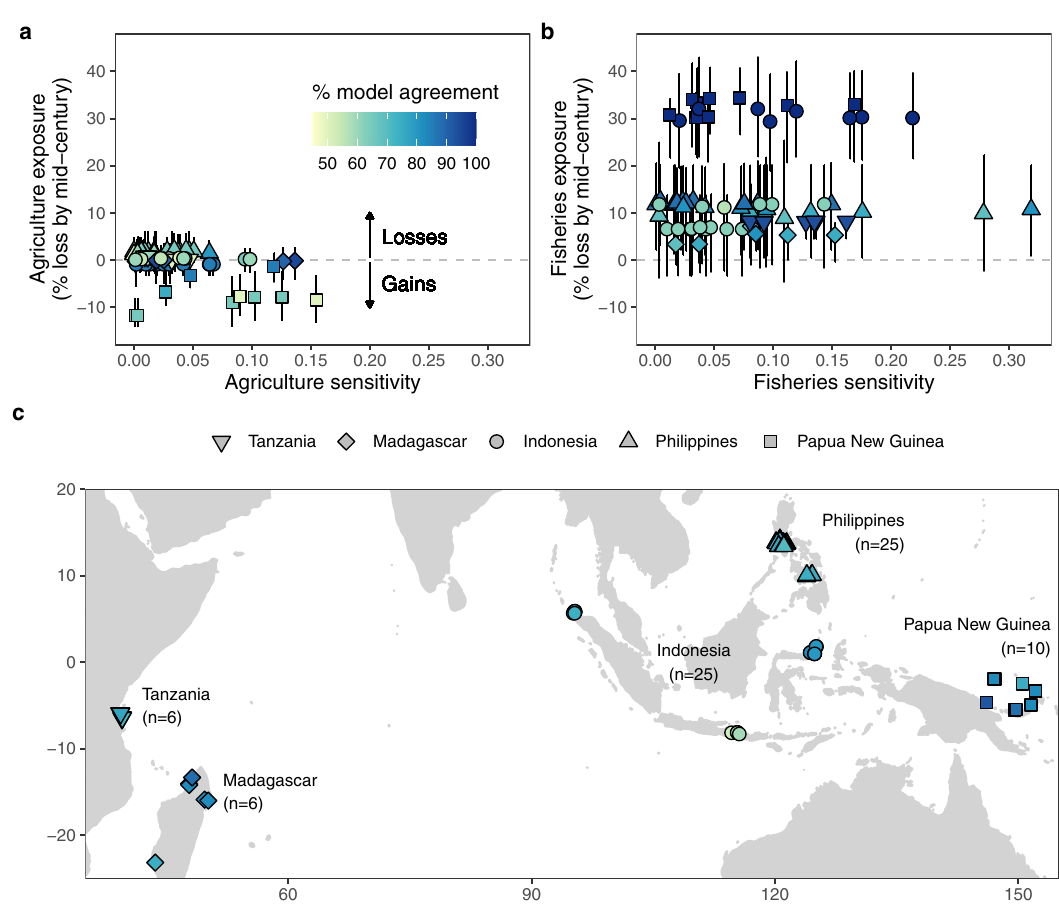
Fig. 1 Potential impacts for (a) agriculture and (b) fi sheries under SSP5-8.5 for (c) all study communities ( n = 72). Potential impacts comprise the exposure (y-axis, measured in potential losses, with error bars showing 25th and 75th percentiles) and sensitivity (x-axis, measured as level of dependence by households). Model run agreement (shown as colour gradient) highlights the proportion of ( a ) crop model runs ( n = 20), ( b ) fi sheries model runs ( n = 16), and ( c ) average of agriculture and fi sheries model runs that agree about the direction of change per site. Point shapes indicate country of each community. Inset map in Supplementary Fig.